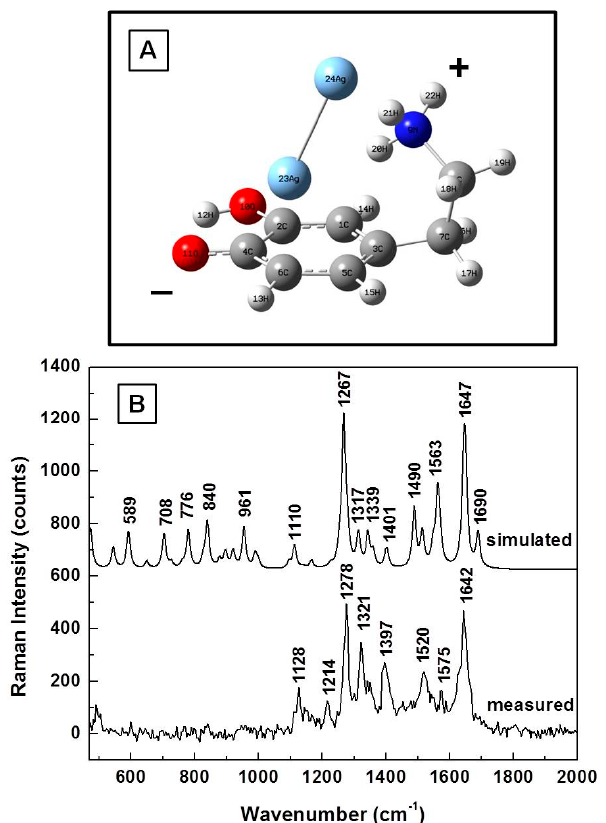
Figure 6. ( A ) Dopamine DA ± structural representation in the proximity of silver; ( B ) Theoretically calculated and experimentally measured Raman vibrations of DA ± , as labeled. The spectra are vertically translated for easier visualization.